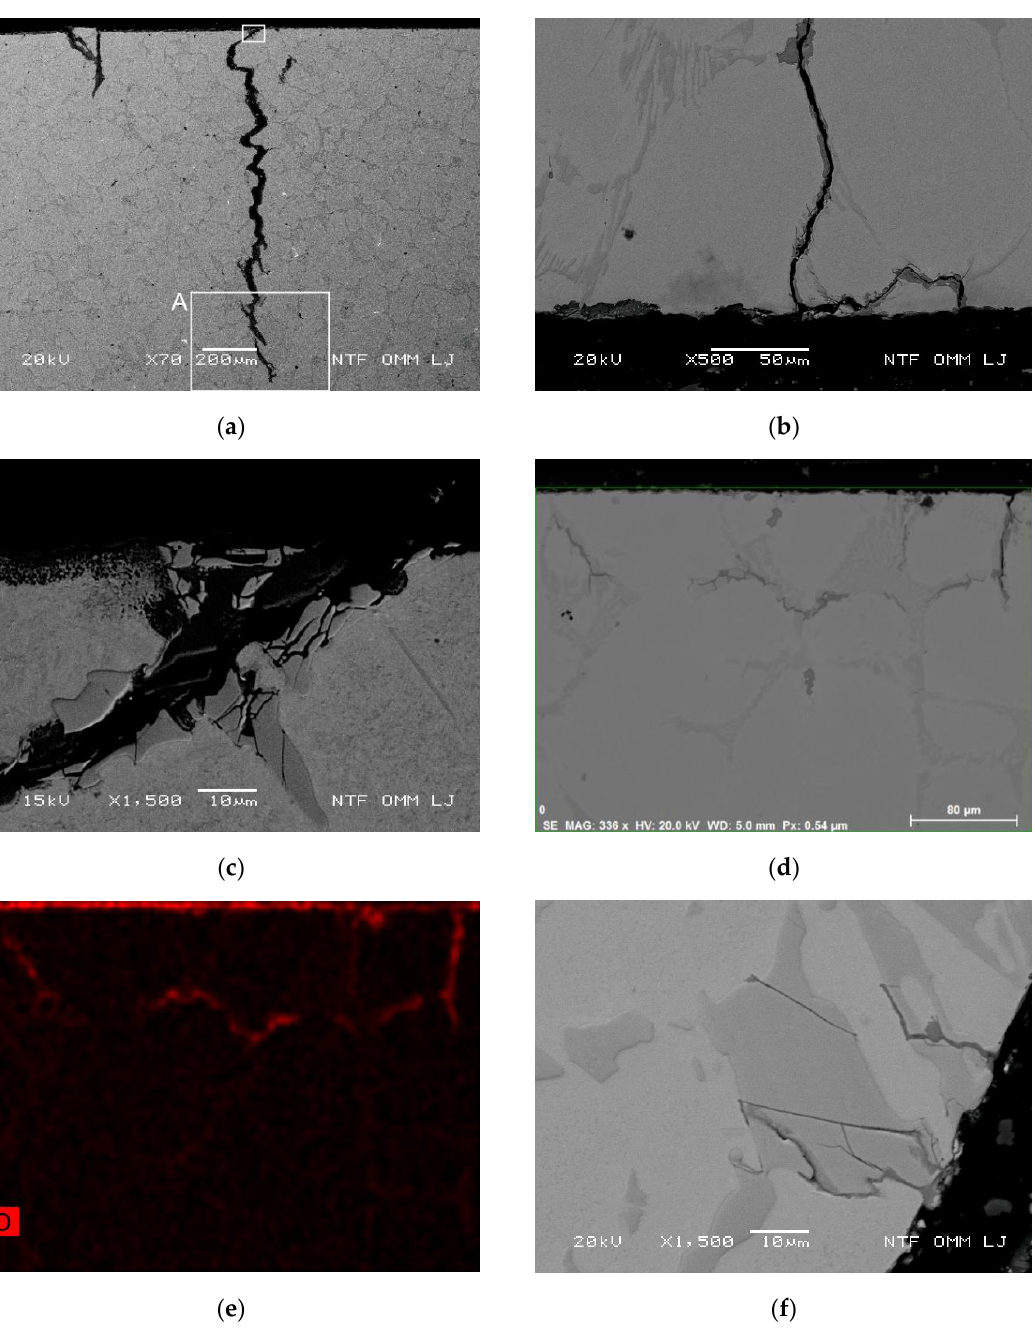
Figure 8. Influence of high effective thermal stress on the oxidation behavior and crack growth: ( a ) cracking and crushing of carbides, crack growth using the carbide pathway and oxidation after 2500 cycles at 700 °C—marked areas of detail A (Figure 11a) and subfigure c; ( b ) crack pathway and oxidation after 1000 cycles at 600 °C; ( c ) crushing and oxidation of thick carbides; ( d ) occurrence of initial internal cracks, cracking and oxidation of cracked and crushed carbides under the cooled surface after 2500 cycles at 600 °C; ( e ) distribution of O in the subfigure d; and ( f ) initial stage of enlarged carbide cracking and crushing at the cooled surface after 1000 cycles at 500 °C.